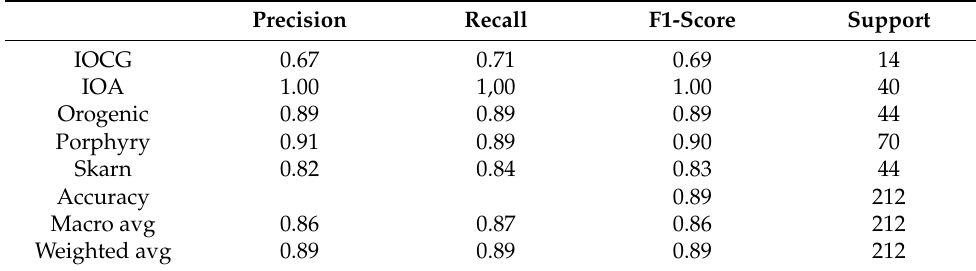
Table 3. Classification